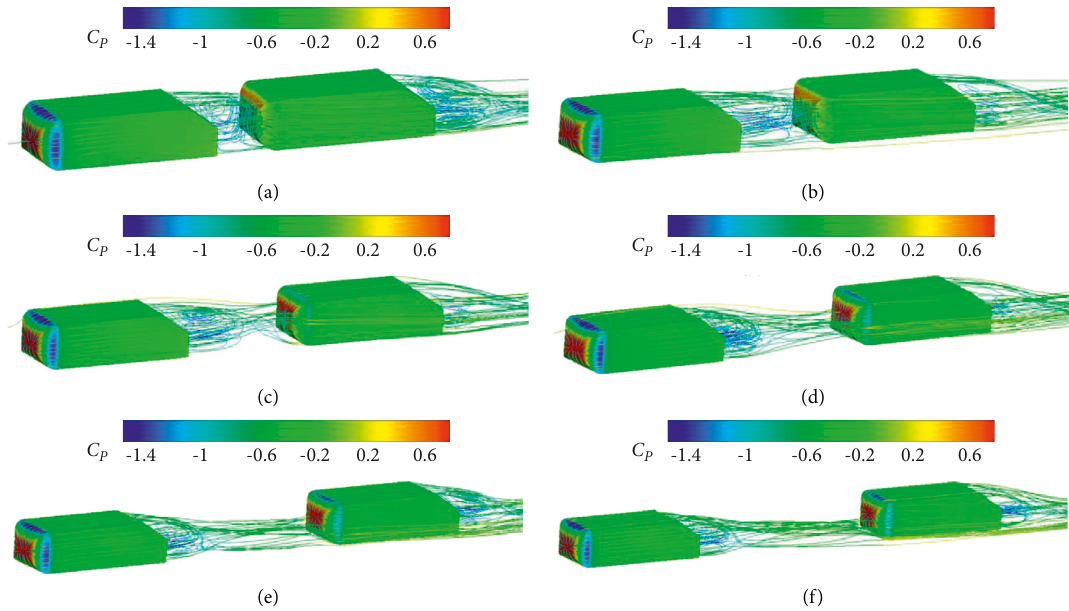
Figure 10: The static pressure and three-dimensional streamlines on the surfaces of two bodies under different inter-vehicle distances, where the three-dimensional streamlines are colored by the x -direction velocity. (a) x/L � 0.25 (b) x/L � 0.5. (c) x/L � 0.75. (d) x/L � 1. (e) x/L � 1.25. (f) x/L � 1.5.